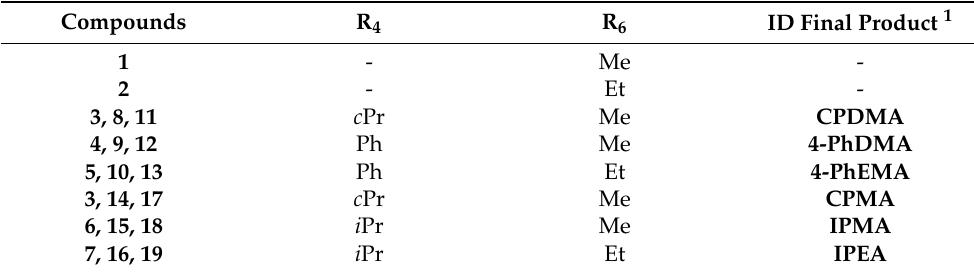
Figure 1. Structure of 4,6,4 ′ -trimethylangelicin (TMA) and 4-isopropyl-6-ethyl-4 ′ -methylangelicin (IPEMA). Table 1. R substituents for the A series of TMA analogs. Figure 2. General structure of TMA analogs. See Tables 1–3 for the R specification. Compounds Table 1. R substituents for the A series of TMA analogs. Compounds